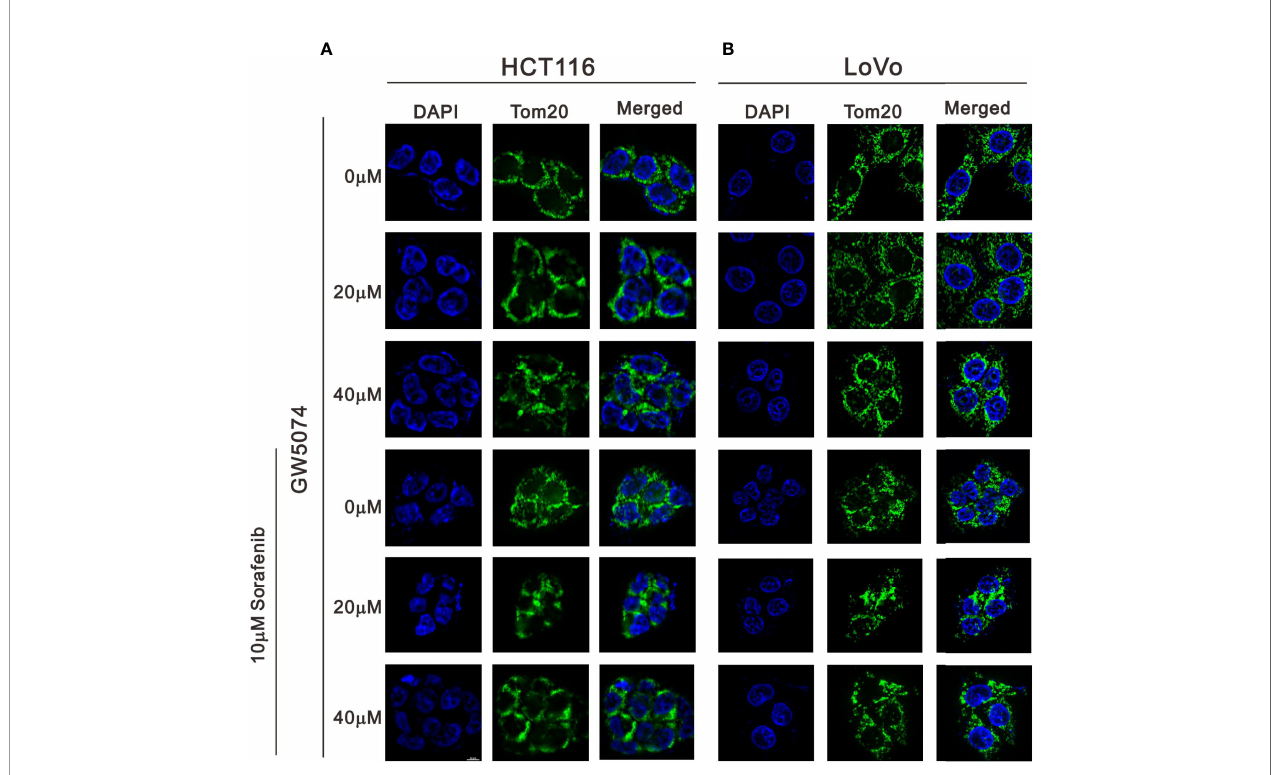
FIGURE 13 | The effects of GW5074 and sorafenib on the expression of Tom20 in HCT116 and LoVo cells. HCT116 (A) and LoVo (B) cells were treated with 0, 20, and 40 µM GW5074 in the absence or presence of 10 µM sorafenib for 24 h and were immune-stained with anti-Tom20 (green) and DAPI (blue). Images were examined under a Leica Thunder microscope with a 100x objective. Scale Bar=10 m